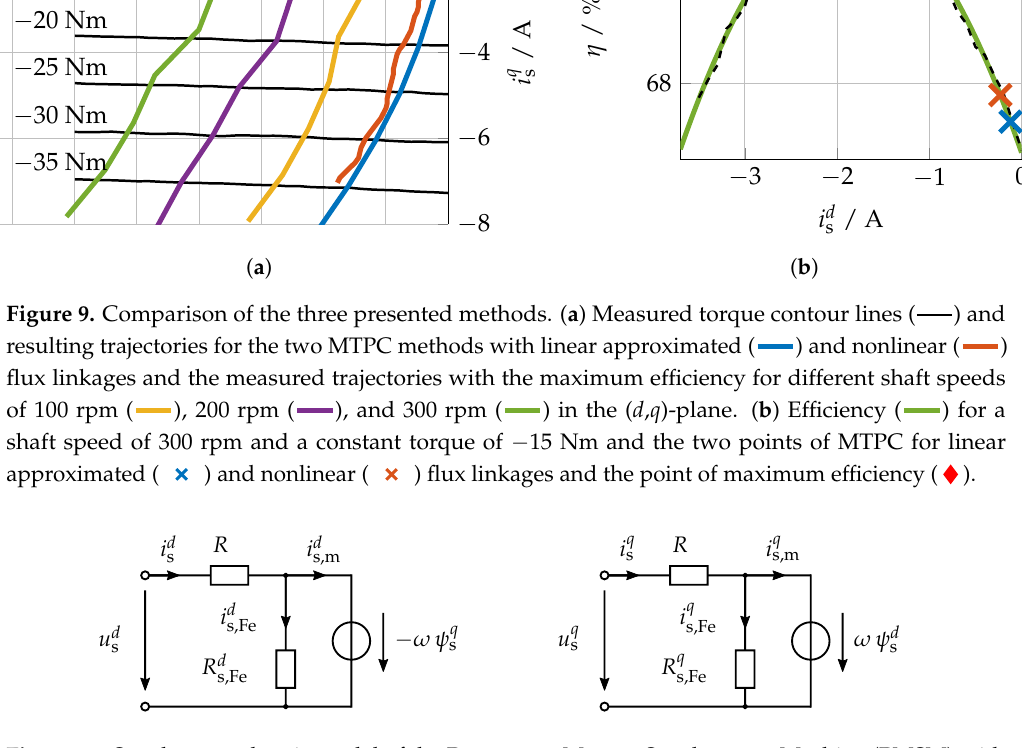
Figure 10. Steady-state electric model of the Permanent-Magnet Synchronous Machine (PMSM) with iron